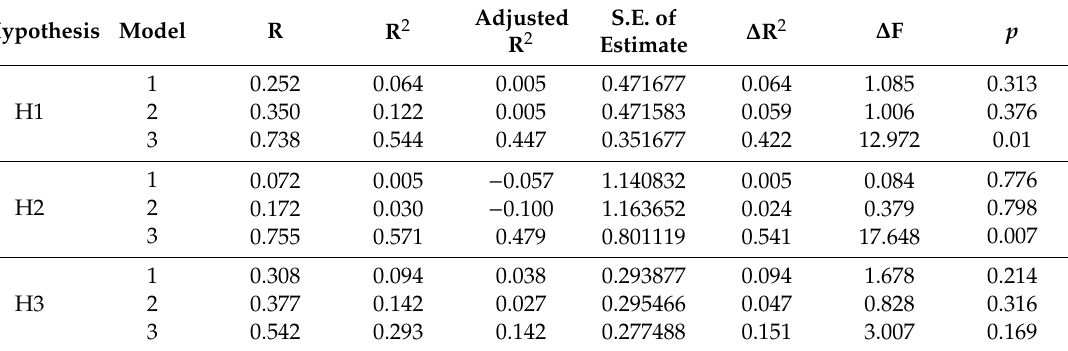
Table 11. Model comparisons and model fit measures.